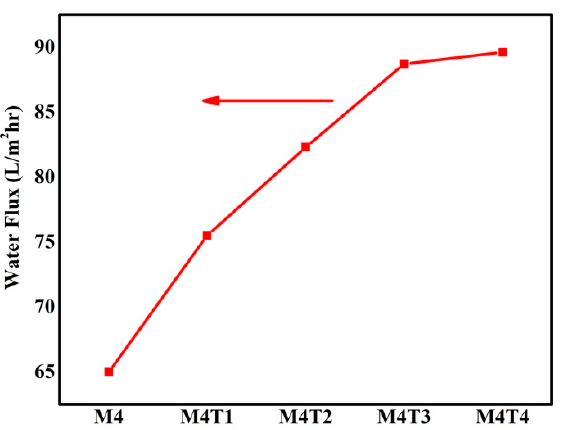
Figure 8. Water flux measurements of the prepared membrane with or without TiO 2 /pore former.